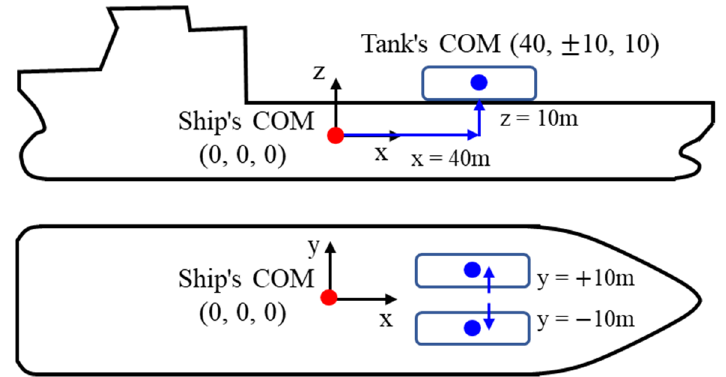
Figure 4. Position of the tank corresponding to the COM of the ship. The LNG properties with density 𝜌 = 4.26 × 10 − 10 (ton/mm 3 ) and viscosity μ = 1.46 × 10 − 10 MPa.s were assigned to the particle elements. To support the solution for the SPH model, the LNG was defined using the Hugoniot type linear equation of state with the parameters of the sound speed of 1.42 × 10 6 mm/s, the slope coefficient of 0, and the Grüneisen ratio equal to 0. The interaction between the LNG particles and the tank structure is defined through contact inclusions considering the particle radius. Figure 5. A typical example for the tank heel analysis model. 3.2. Even Keel Condition The SPH analyses for the even keel condition are necessary to check if the modeled particles maintain the intended filling head under the gravity load of 9810 mm/s 2 . We assumed the Vanzetti pump [31] as an LNG suction pump, which is located at the center of the sump tank. The net positive suction head available (NPSHa) was 940 mm, which corresponded to the filling ratio of 7.76%, as shown in Figure 3c. Hereafter it is denoted as the reference filling ratio. Based on the reference filling ratio, the SPH models with the increased filling ratios were generated to check the suction pump submergence even under the dynamic ship motion conditions. The SPH models are summarized in Table 1, where the filling ratios ranged from 7.76% to 17%. A probing bar was cantilevered at the center of the sump tank bottom. Its free end of Model 1 was aligned with the filling head height, as delineated in Figure 5.